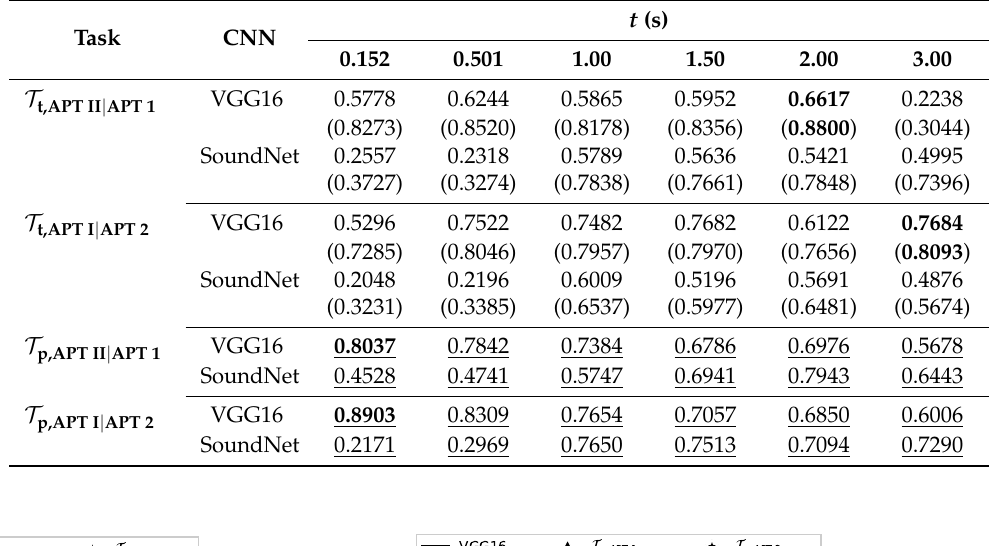
Table 5. Inter-floor noise classification knowledge transfer results with t variation. The values are F1 score of the source type knowledge transfer results. The values in the parentheses are the F1 scores when the HH and HD categories are assumed to be the same category. The underlined values are rearranged localization knowledge transfer results to their corresponding floors.